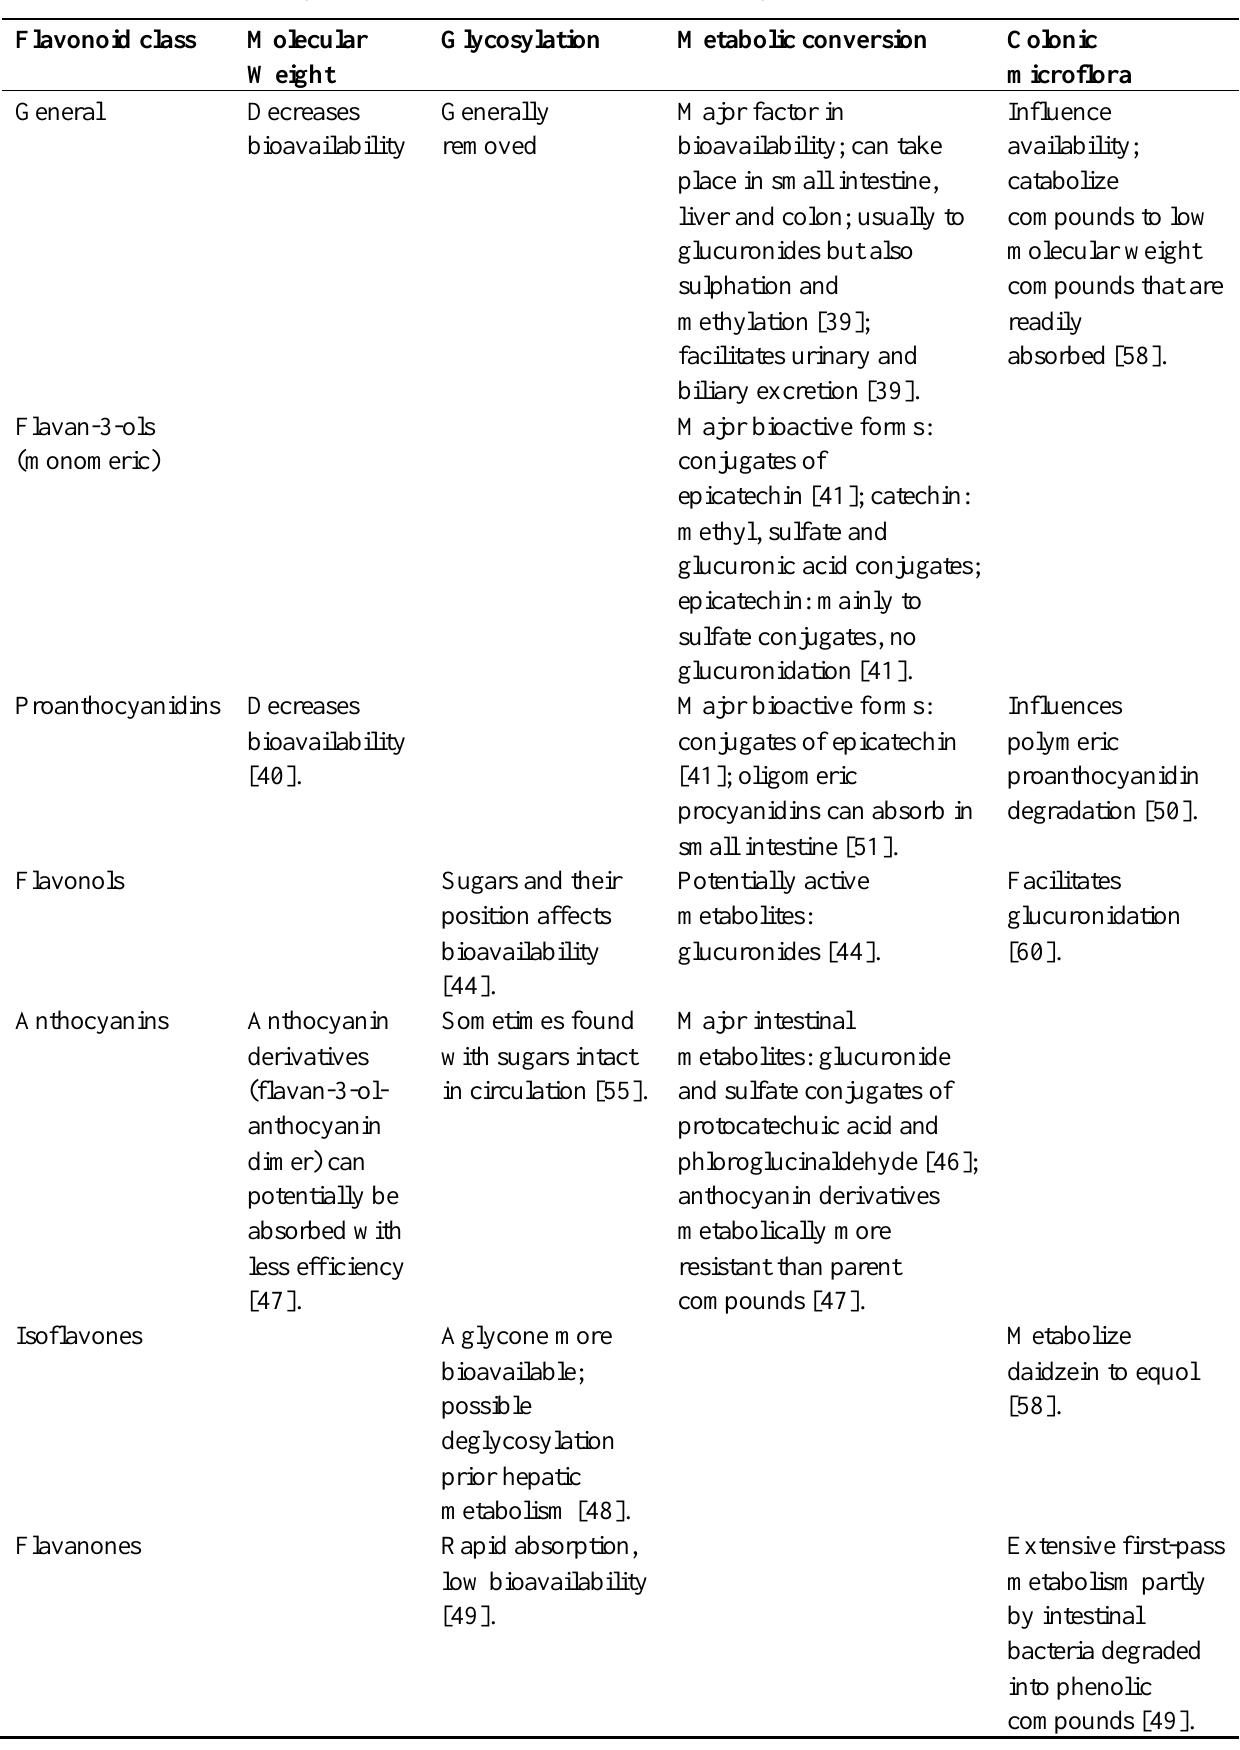
Table 2. Summary of the metabolism and bioavailability of flavonoid classes discussed. Flavonoid